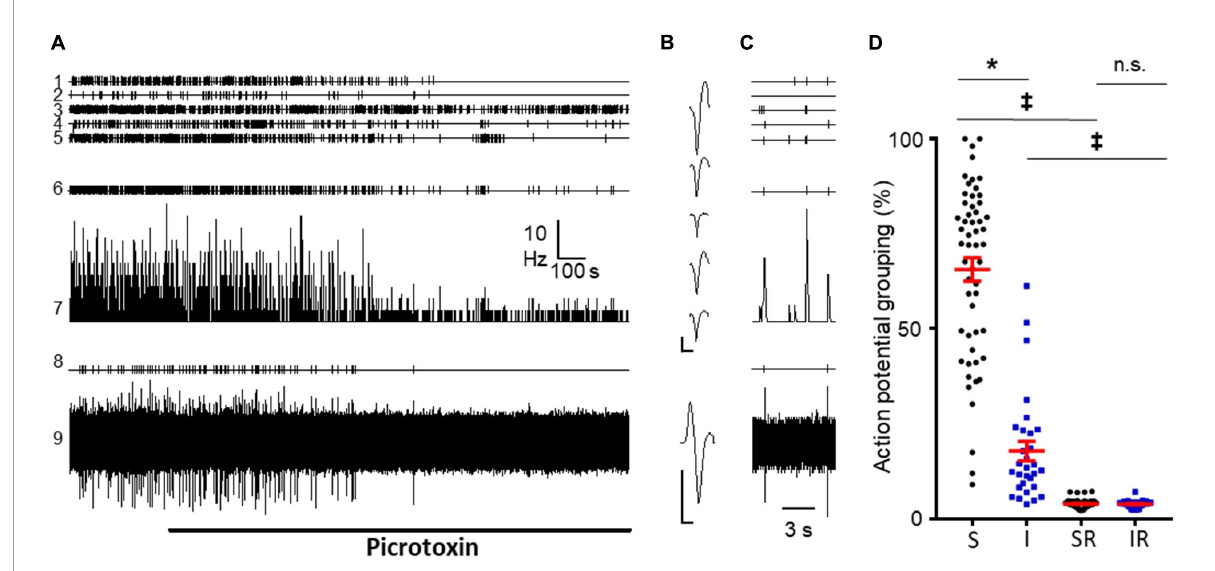
FIGURE4 Effect of picrotoxin perfusion on DRRs and population bursts. (A) Recordings from an experiment from a naïve mice showing effects of picrotoxin (20 µ M) on five different dorsal horn neurons (channels 1–5). Channel 6 correspond to population burst marks; channel 7 shows mean frequency graph for neurons in 1–5 considered together; channel 8 shows time stamps for action potentials from a primary afferent; channel 9 is the corresponding original recording from the afferent. Note the potent inhibitory effect of picrotoxin on spikes generated by the afferent. In contrast, picrotoxin inhibited only partially the activity of dorsal horn neurons and reduced frequency and amplitude of bursts. (B) Spike forms from dorsal horn neurons (1–5 in panel A ) and from the primary afferent (9 in panel A ). Calibration bars 0.2 mV and 1 ms. (C) Shows three population bursts in an expanded time base prior to PTX perfusion. (D) Graph shows the actual grouping of action potentials in population bursts for neurons sensitive (S) and insensitive (I) to picrotoxin (* for p < 0.0001, Mann–Whitney test). Columns 3 and 4 show the expected grouping values from random distribution of spikes in sensitive (SR) and insensitive (IR) neurons. Note how actual grouping values are higher than expected by chance even in the group of neurons insensitive to picrotoxin ( ‡ for p < 0.0001, Wilcoxon matched-pairs signed rank test). No significant differences were found between randomized groups ( p = 0.6857; Mann–Whitney